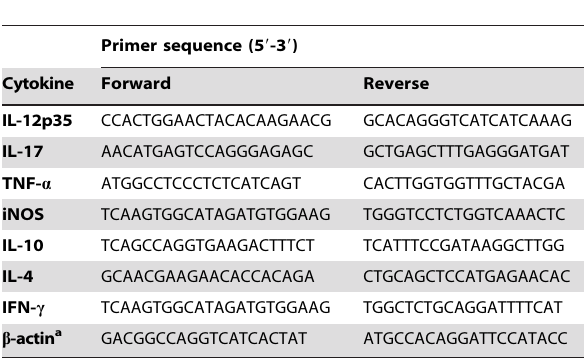
Table 1. Nucleotide sequences of primers used in the